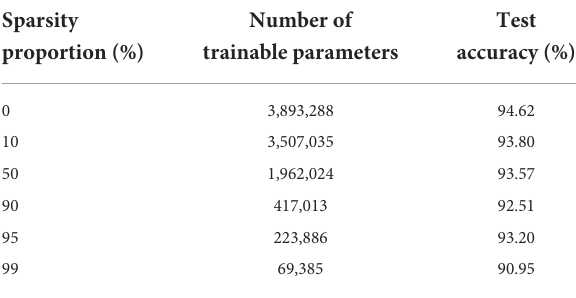
TABLE 10 Results on the SHD dataset for a recurrent RadLIF network of size 3 × 1,024, with a sparser connectivity in all hidden